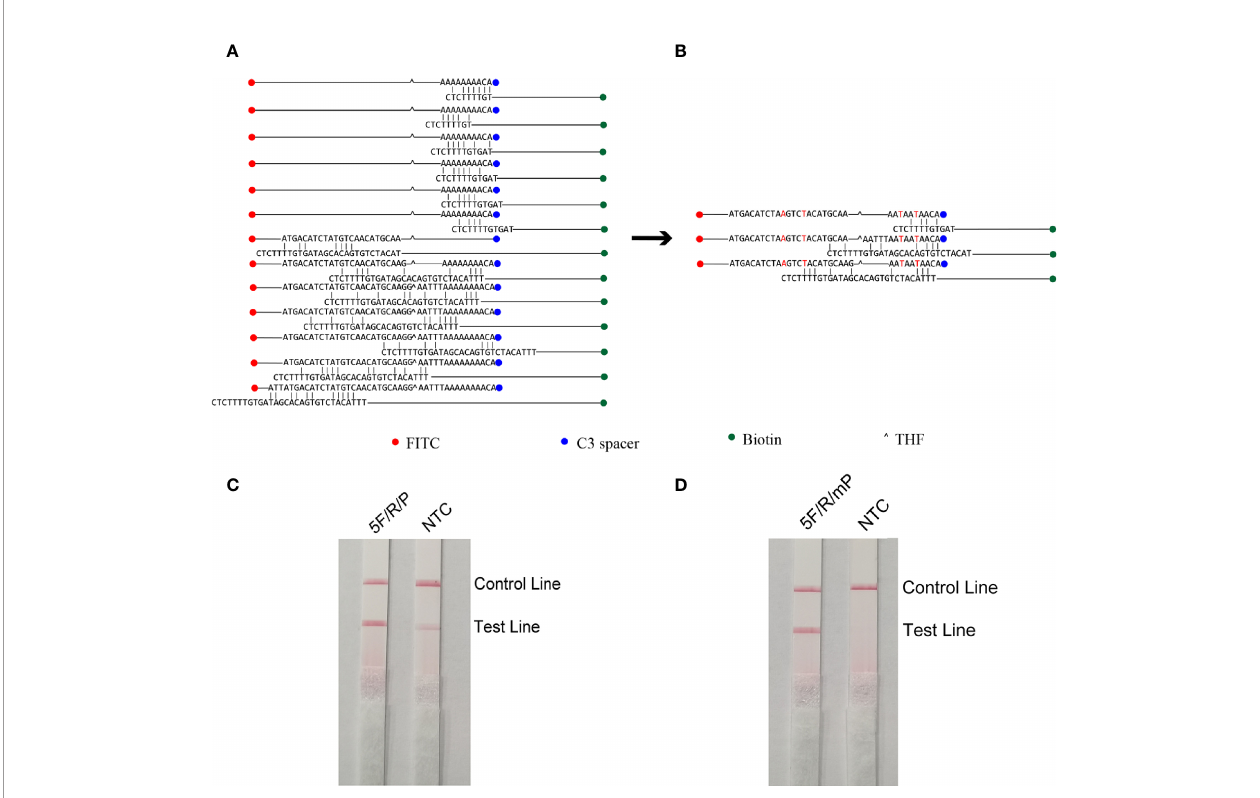
FIGURE 4 | Probe design screening strategy. (A) Before base substitution, the probe and reverse primer form a cross-dimer. (B) After base substitution, the probe and reverse primer form a cross-dimer. (C, D) LFS results of RPA ampli fi cation products. The name of each primer-probe group is marked above the corresponding band, and the NTC lane is a template-free control for each primer-probe